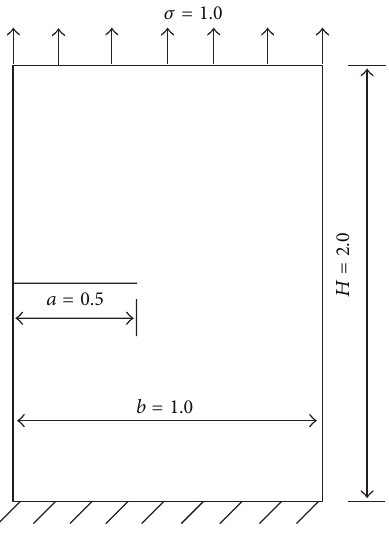
Figure 8: Sheet with edge crack under